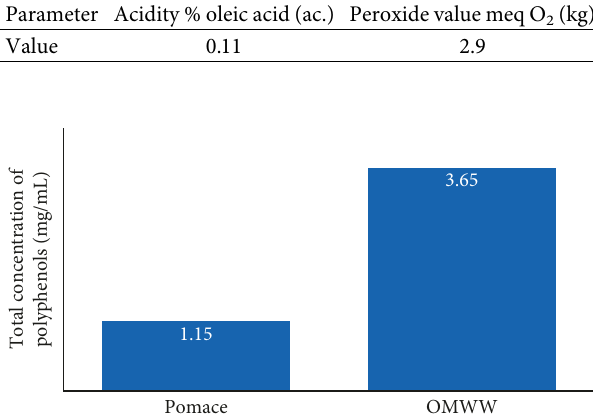
Table 2: Butter characteristics.